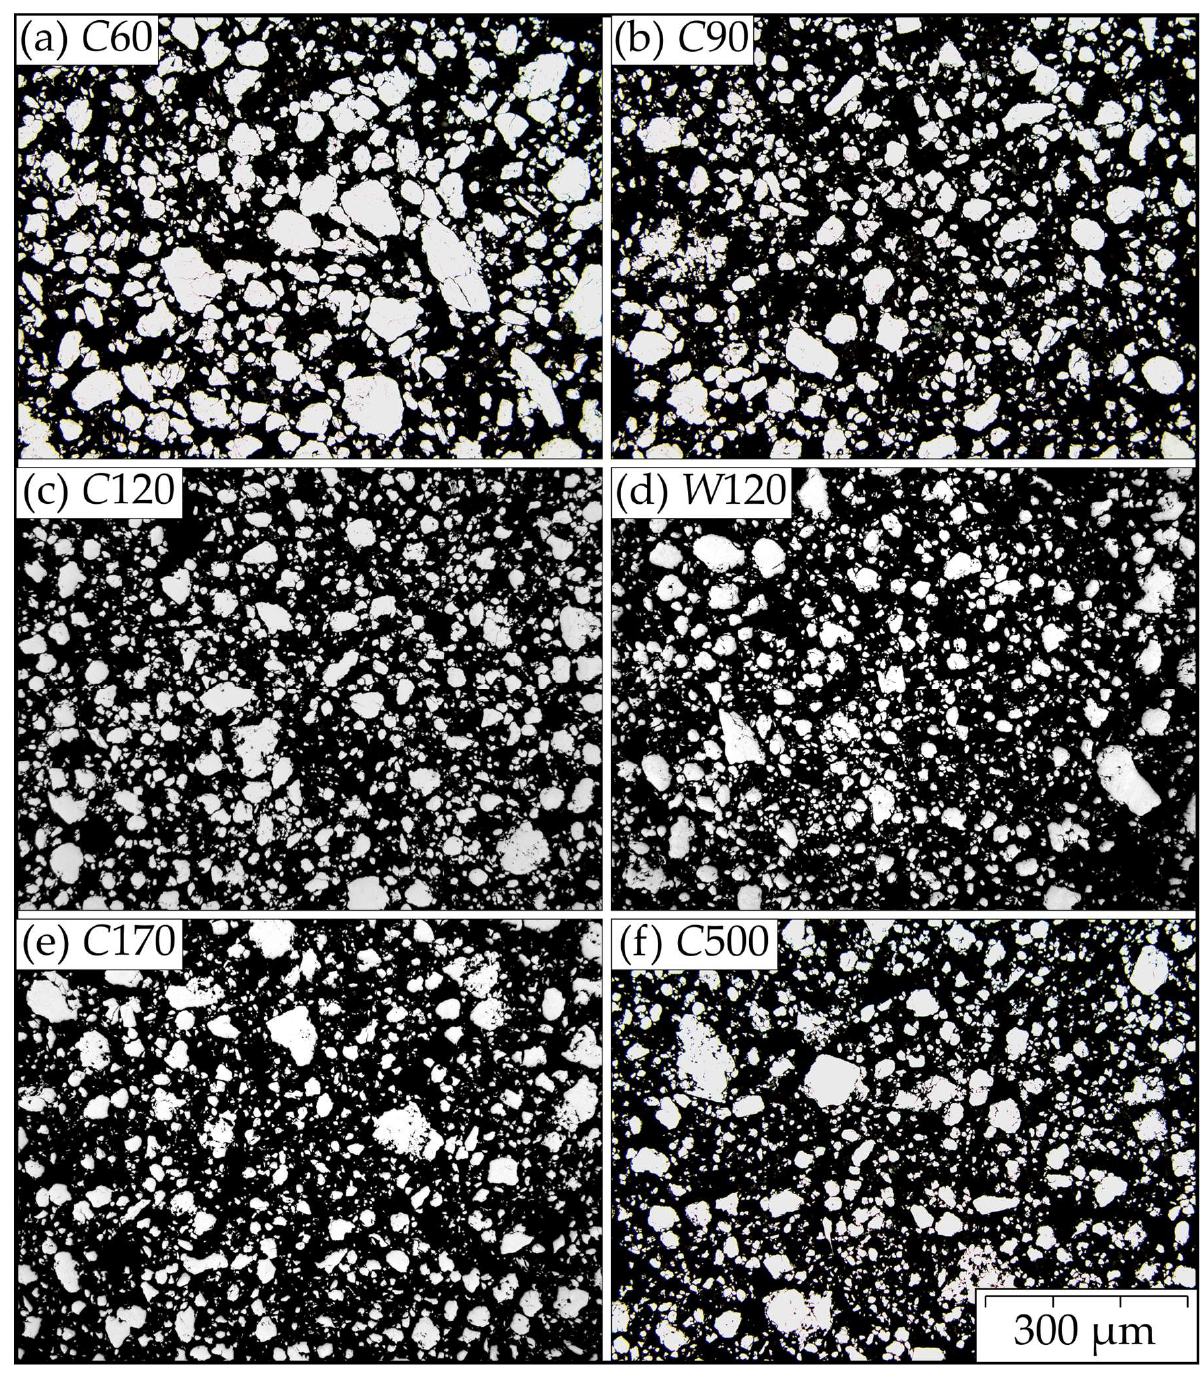
Figure 1. Representative metallographic cuts of powders ( a ) C 60, ( b ) C 90, ( c ) C 120, ( d ) W 120, ( e ) C 170, and ( f ) C 500 (optical microscope, the contrast is adjusted for better distinguishing between the powder particles (white) and the resin (black)).